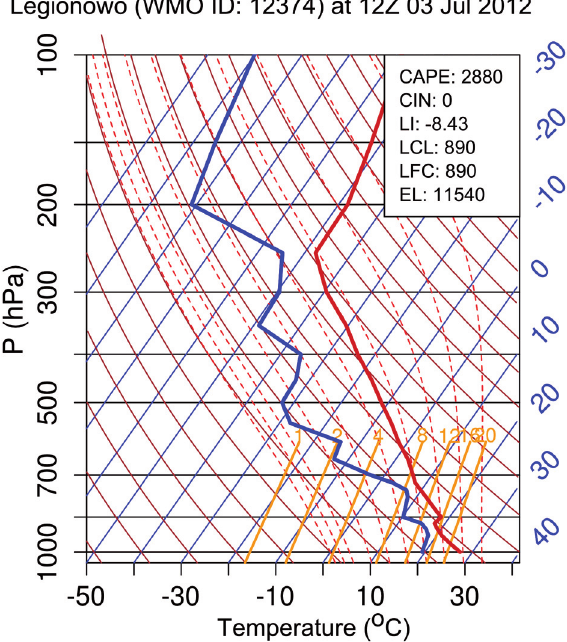
Fig. 7. Skew-T atmospheric sounding diagram derived from Legionowo station on 3rd July 2012 1200 UTC (based on University of Wyoming database raw sounding